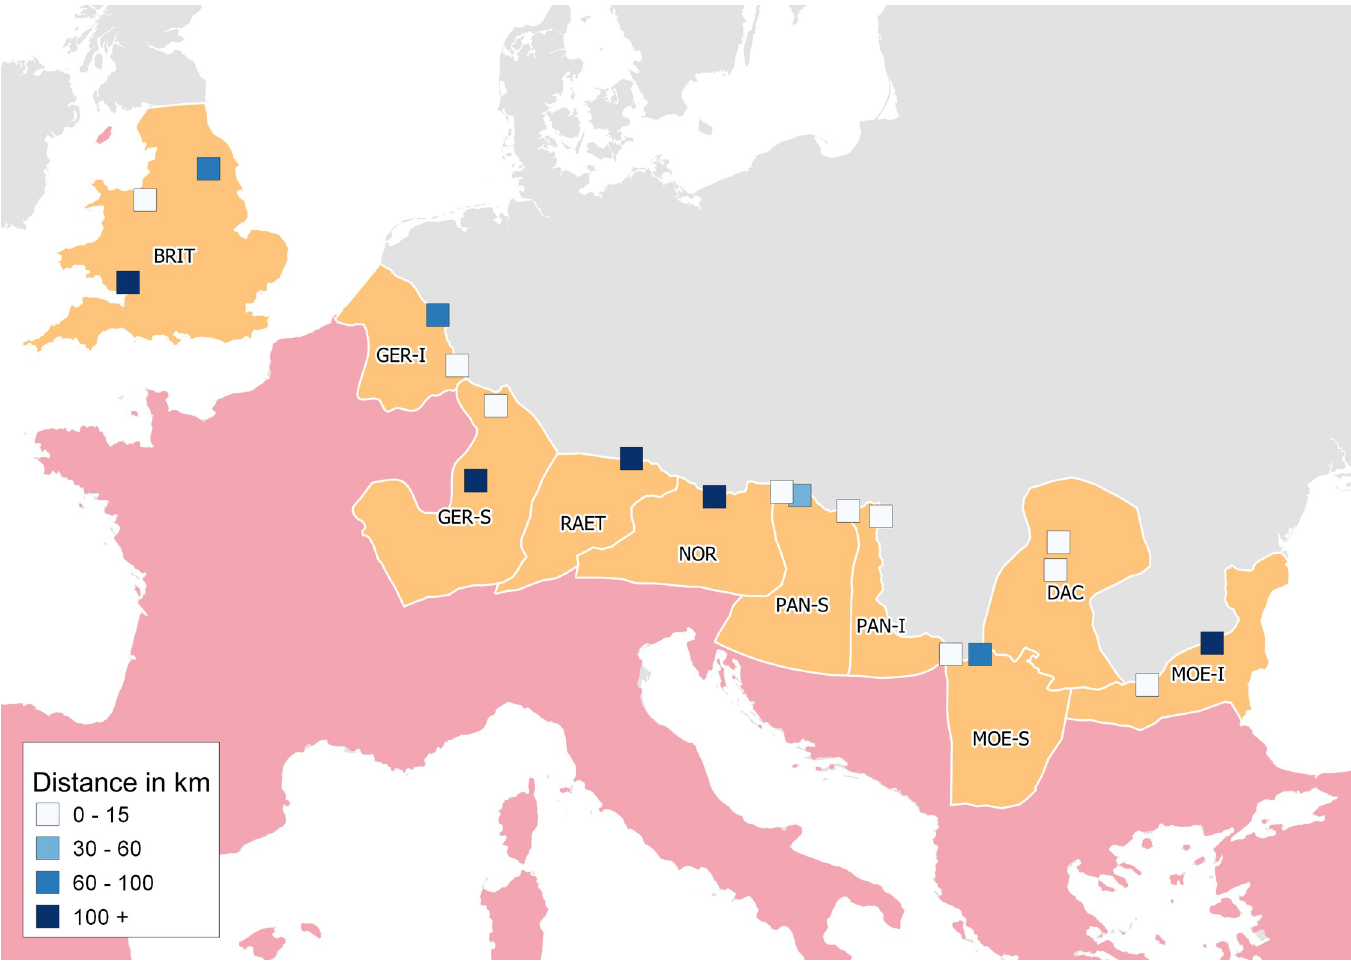
Fig 4. Long-term legion bases in the area of interest and their distance in the transportation network to their nearest proxy for the worship of Asclepius. Distance ranges are indicated in the legend. Sources: Natural Earth [31]; Ancient World Mapping Center (AWMC) [32]—Reprinted from AWMC database of shapefiles [32] under a CC BY license, with permission from AWMC, original copyright 2012; Dataset of the variables